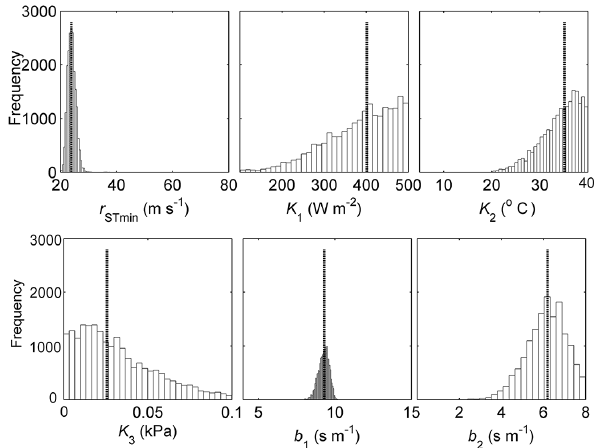
Figure 4. Histograms of samples from the posterior distributions of the parameters. The dashed vertical lines indicate median parameter